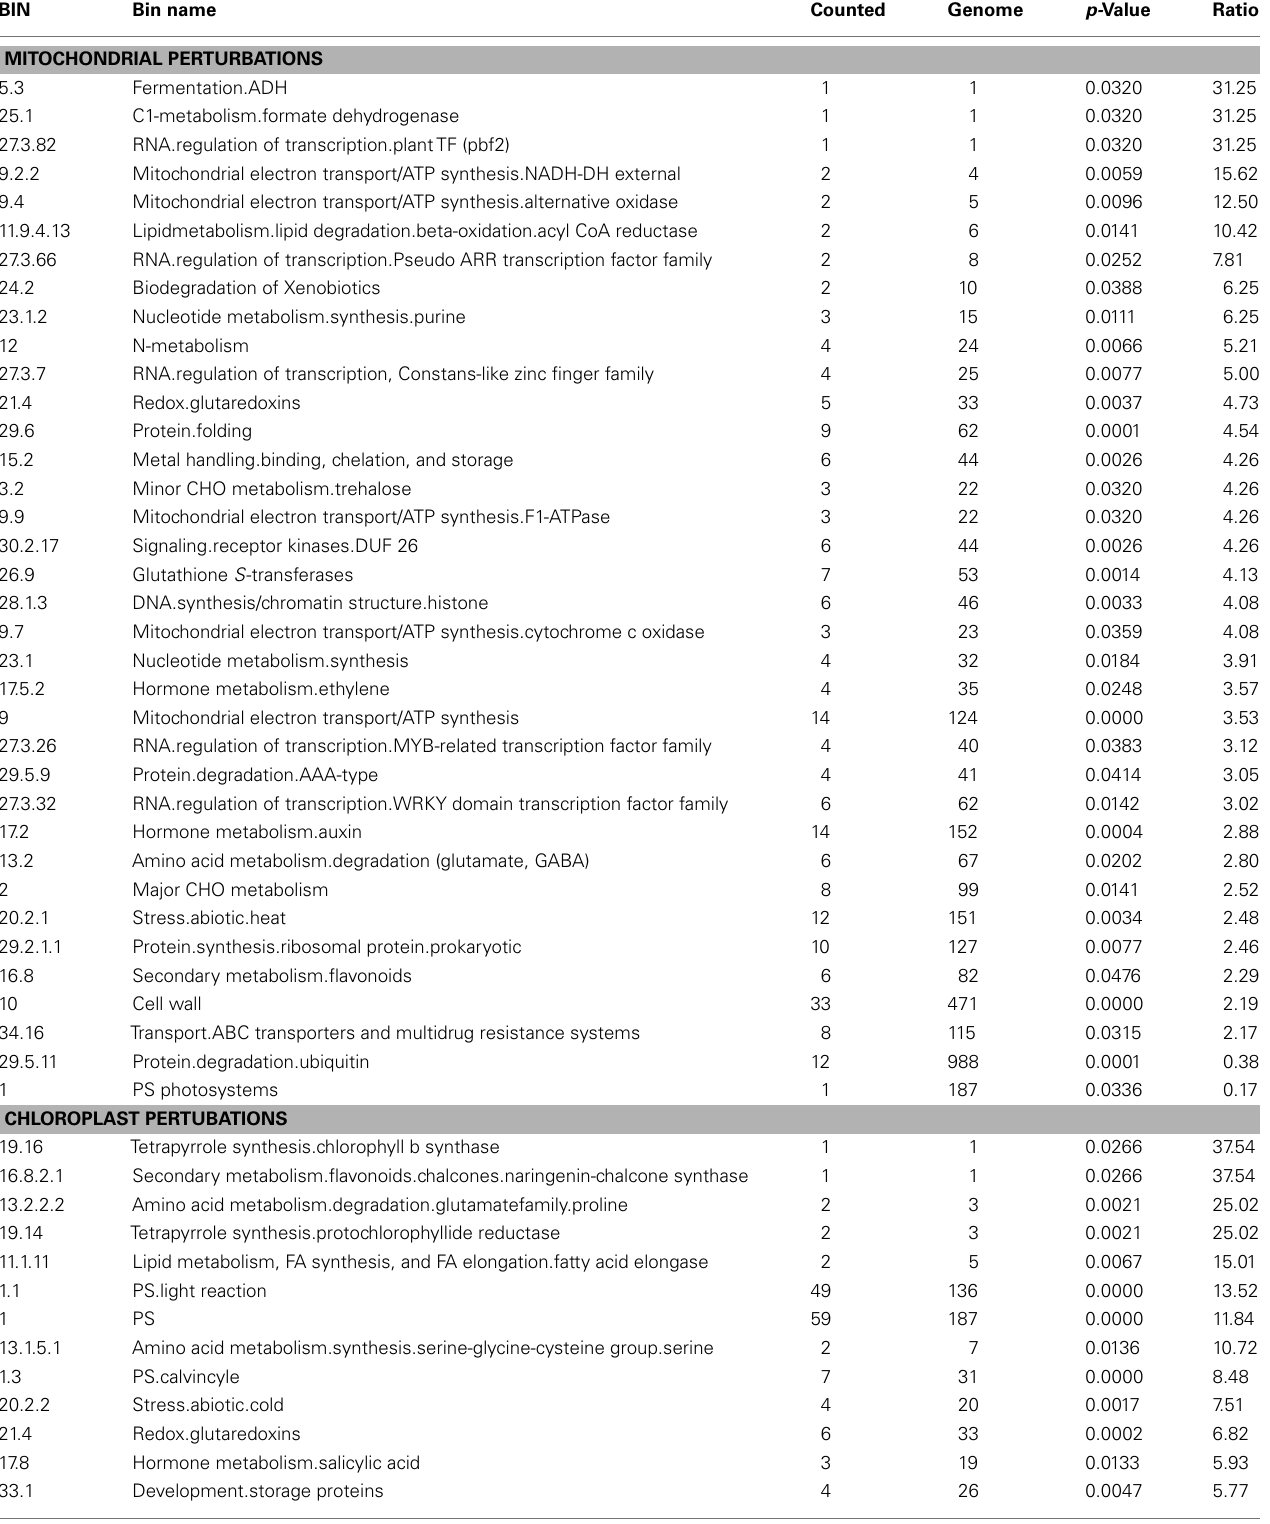
Table 3 | Significantly over- or underrepresented functional categories among probe sets commonly responding to mitochondrial (top) or chloroplast (bottom) dysfunction as determined by PageMan